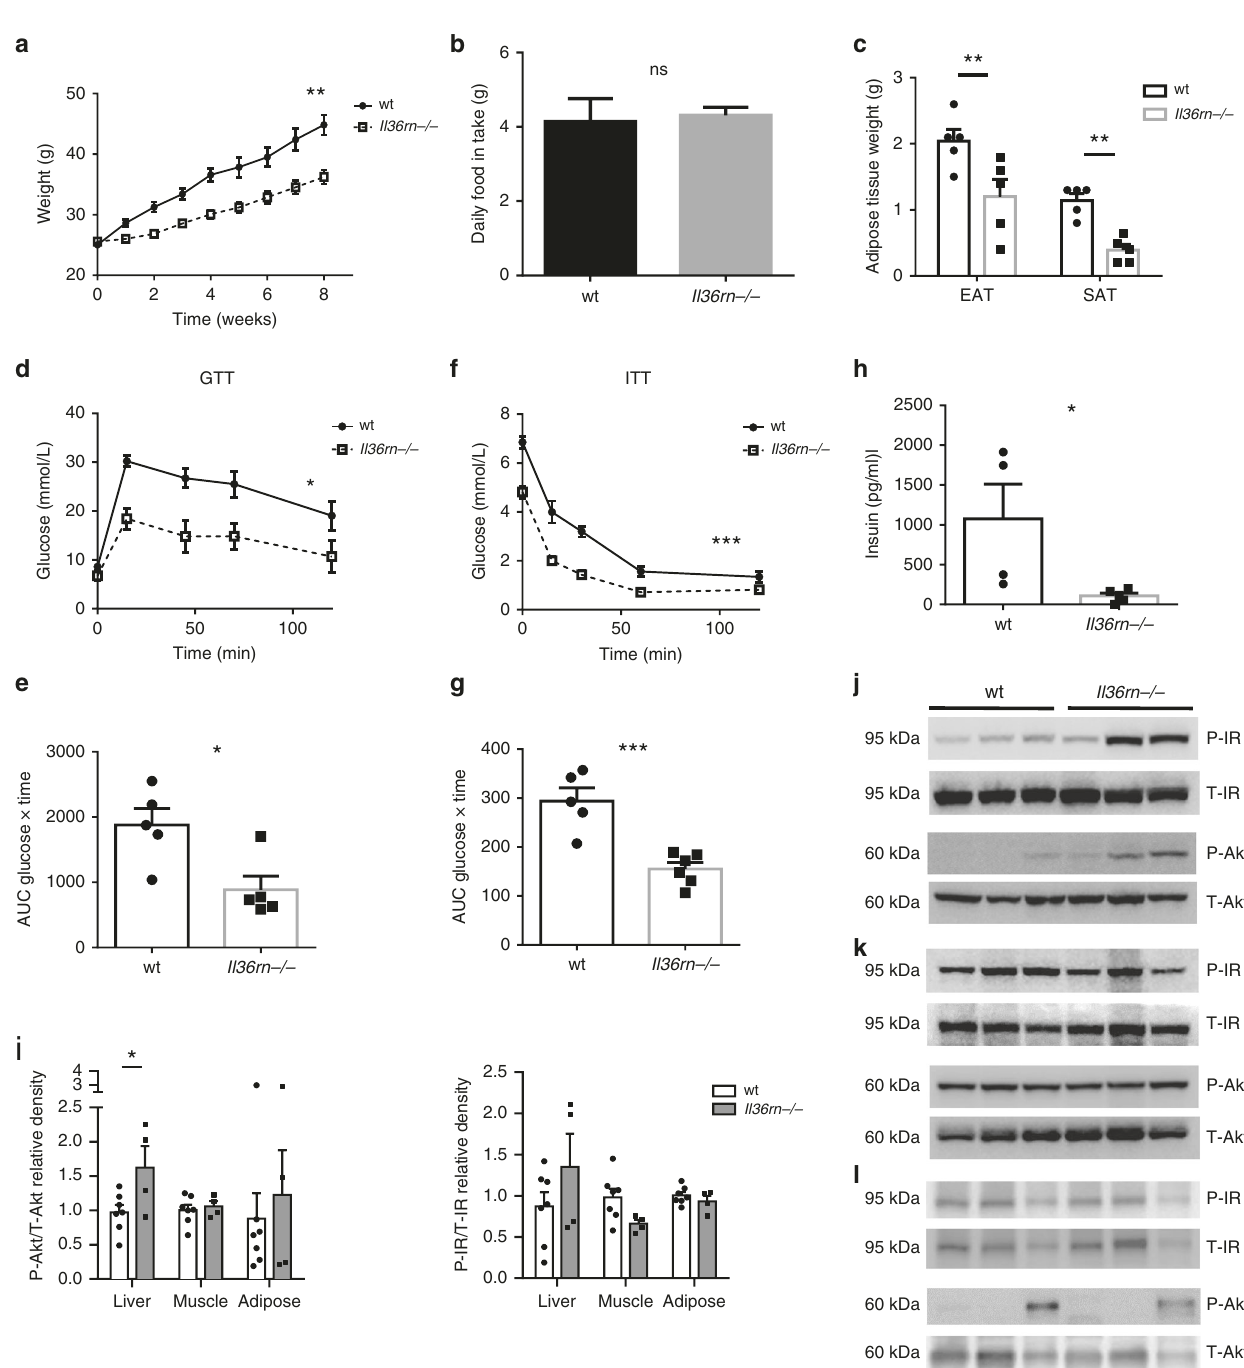
Fig. 3 Il36rn − / − mice are protected from diet-induced obesity and insulin resistance. a – h Male Il36rn − / − and wt mice of the same age were fed a HFD (60 kcal% fat) for 8 – 10 weeks starting from 8 weeks of age. Weights ( a ) and daily food intake per mouse ( b ) were monitored and data shown are pooled from three independent experiments ( wt n = 15, Il36rn − / − n = 22). c EAT and SAT depots mass was measured after 10 weeks in HFD. d , e Intraperitoneal GTT on wt and Il36rn − / − mice after 8 weeks in HFD; glucose over time after i.p. glucose injection ( d ) and AUC ( e ) shown. f , g Intraperitoneal ITT on wt and Il36rn − / − mice after 9 weeks in HFD; glucose over time after insulin bolus-injected i.p. ( f ) and AUC ( g ) shown. h Fasting blood insulin levels for wt and Il36rn − / − mice after 10 weeks in HFD. i Relative protein expression levels of phospho-Akt (P-Akt)/total Akt (T-Akt) and phospho-insulin receptor β (P-IR)/total insulin receptor β (T-IR) in the liver, skeletal muscle and EAT of wt ( n = 7) and Il36rn − / − ( n = 4) mice after insulin injection, as indicated by densitometry analysis of western blot data (in Source Data fi le). j – l Protein expression of P-IR, T-IR, P-Akt and T-Akt in the liver ( j ), skeletal muscle ( k ) and EAT ( l ) of representative wt ( n = 3) and Il36rn − / − ( n = 3) mice after insulin injection. Data represent means ± SEM. Statistical analysis using two-tailed unpaired student ’ s t- test for ( c ), ( g ) and ( i ), two-tailed Mann – Whitney test for ( b ), ( h ) and ( e ) and RM two-way ANOVA for ( a ), ( d ) and ( f ). ns p > 0.05, * p < 0.05, ** p < 0.01, *** p < 0.001. Source data are provided as a Source Data fi